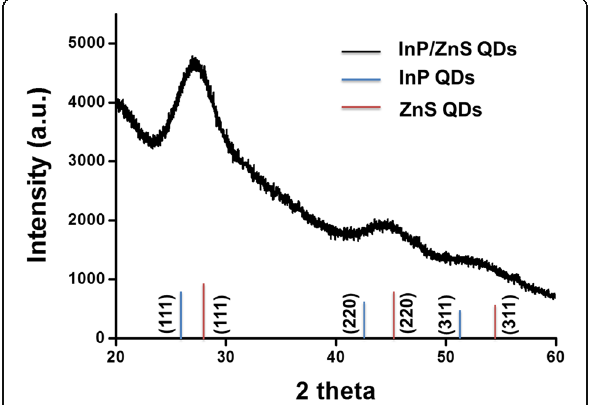
Fig. 2 XRD patterns of InP/ZnS core/shell QDs. The XRD reflection peaks of InP QDs and ZnS QDs with typical zinc-blend